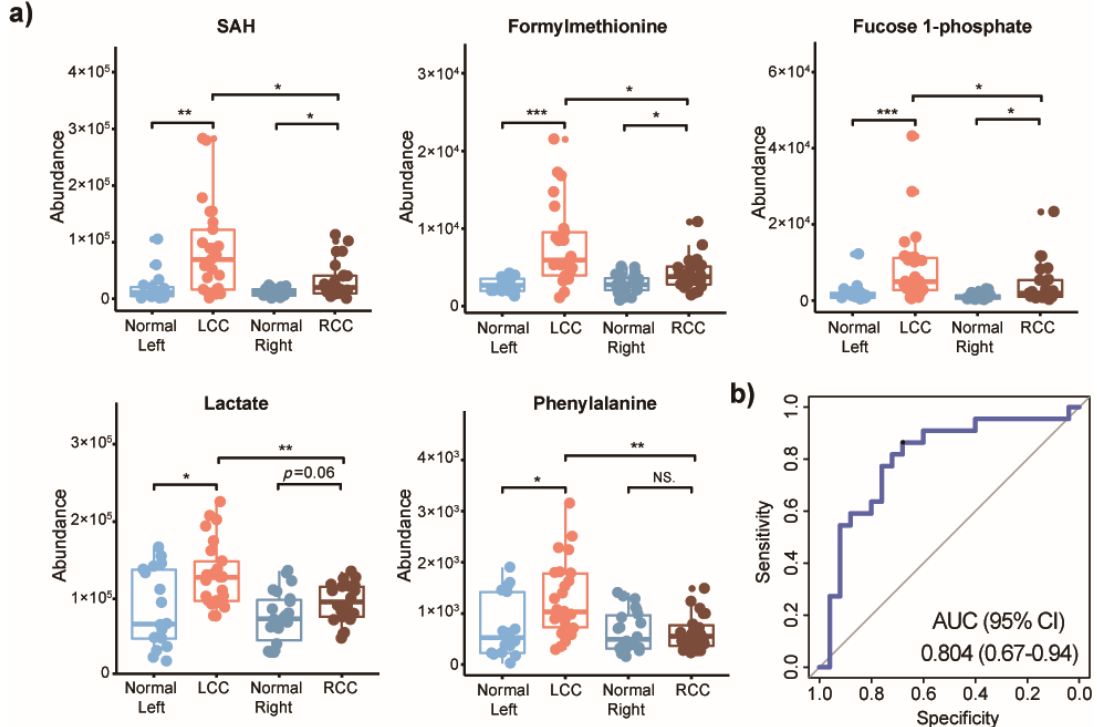
Figure 3. Potential metabolic biomarkers for stage I LCC and RCC. ( a ) Abundance of S-adenosylhomocysteine (SAH), formylmethionine, fucose 1-phosphate, lactate, and phenylalanine in left-sided normal colon (Normal Left, n = 17), left-sided colon cancer (LCC, n = 25), right-sided normal colon (Normal Right, n = 22), and right-sided colon cancer (RCC, n = 22). Nonparametric Kruskal–Wallis rank sum test with pairwise Wilcoxon Mann–Whitney U test, p values adjusted for false discovery rates (FDR) (Benjamini–Hochberg). * p < 0.05, ** p < 0.01, *** p < 0.001, NS. = not significant. ( b ) ROC curve plot of predictive model, based on five metabolic biomarkers using random forest (RF), di ff erentiating LCC from